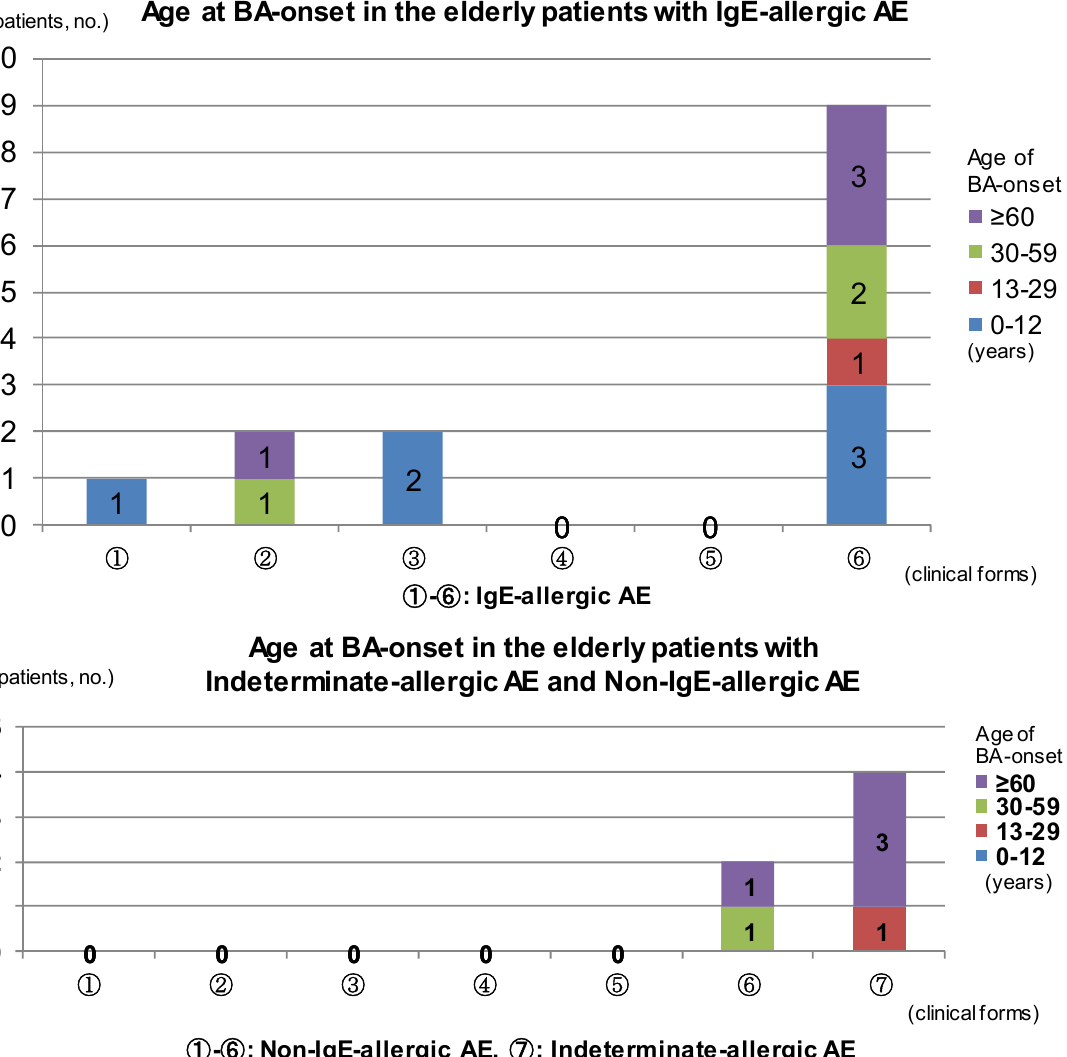
Figure 2. Age at bronchial asthma (BA) onset in elderly patients with atopic eczema. Abbreviations: AE, atopic eczema; BA, bronchial asthma; ① childhood-onset AE, outgrow-recurrence type; ② childhood-onset AE, continuous type; ③ adolescent